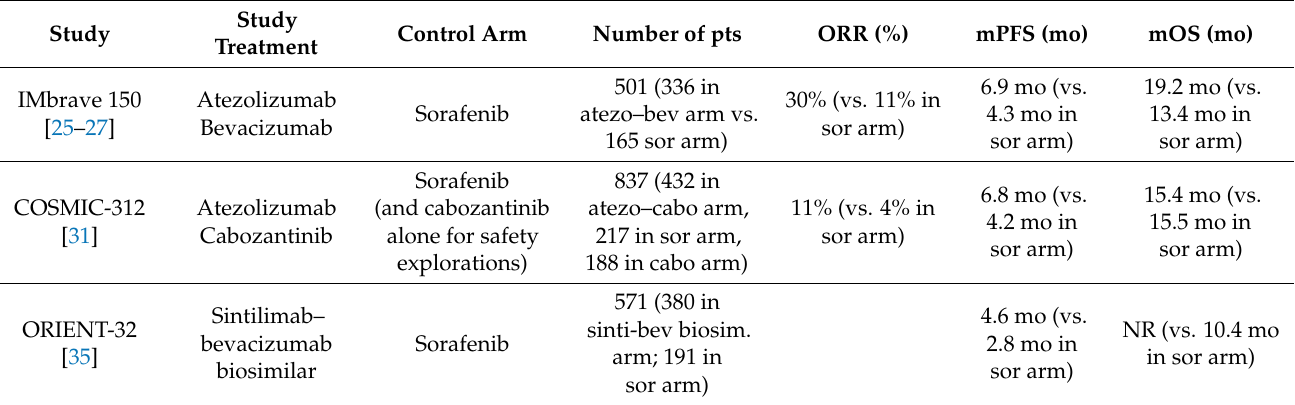
Table 2. Available results of phase III studies evaluating ICI in combination with antiangiogenic agents in advanced HCC.